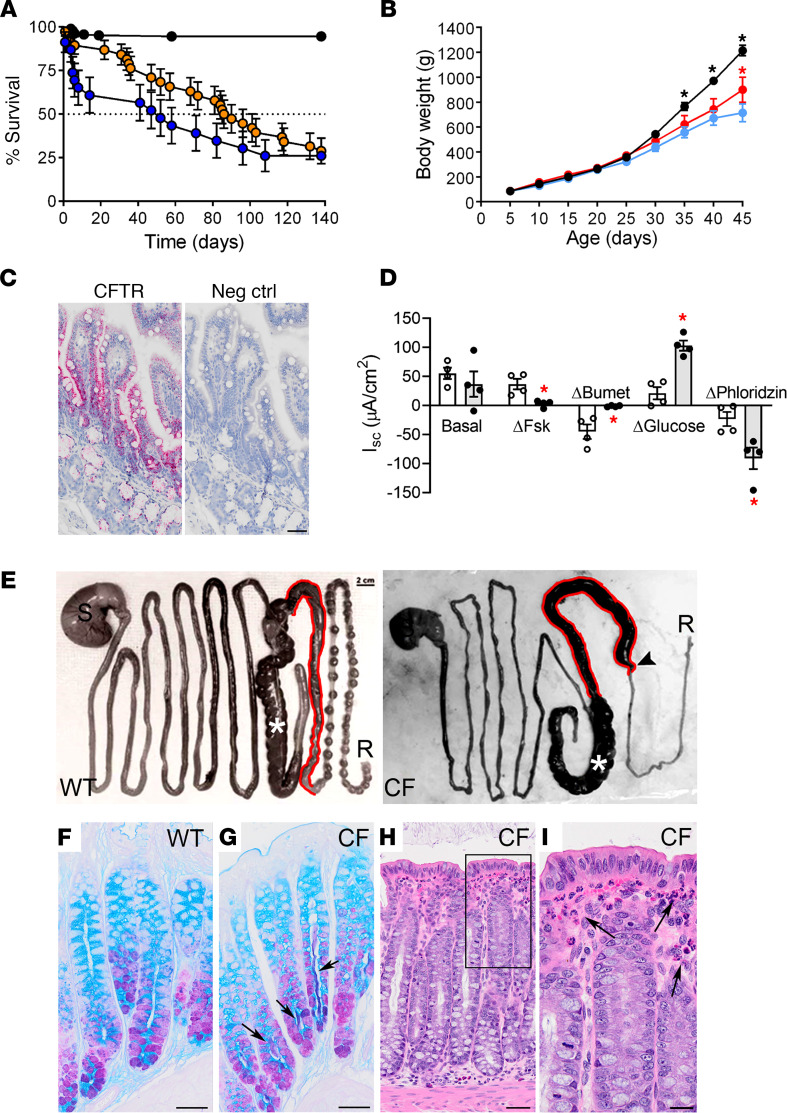
Characterization of CF rabbit gastrointestinal function, weight gain, and mortality.(A) Survival curves for WT and heterozygous rabbits (black, n = 190), CF rabbits on Golytely (blue, n = 23), and CF rabbits on Golytely, Bio-Serve, and abdominal palpation-directed GI therapy (orange, n = 38). (B) Weight gain for WT rabbits (black, n = 32), untreated CF rabbits (blue, n = 17), and CF rabbits treated with Golytely starting at P14 (red, n = 15). *P < 0.05 versus untreated CF, 2-way ANOVA with Tukey’s test for multiple comparisons. (C) mRNA in situ hybridization for rabbit CFTR or negative control (RNAscope, red chromogen) on sections of WT jejunum. Scale bar: 50 μm. Representative micrographs from n = 2 rabbits. (D) Ussing chamber characterization of freshly excised jejunal tissue from WT (white bar, white dots) and CF (gray bar, black dots) rabbits at approximately P52, illustrating short-circuit currents (Isc) under basal conditions, and after forskolin stimulation (ΔFsk), bumetanide inhibition (ΔBumet), glucose addition (Δglucose), and phloridzin inhibition. n = 4/genotype, *P < 0.05 versus WT. Unpaired, 2-tailed t test with Welch’s correction for unequal variance. (E) Freshly excised WT and CF gastrointestinal tract, deconvoluted from stomach (S) to rectum (R). Asterisk represents cecum. The proximal colon (highlighted in red) was dilated in CF rabbits as compared with WT, and there was a paucity of stool pellets in the distal colon of CF rabbits. Arrow indicates a site of obstruction. (F and G) (AB-PAS stained cross section of distal colon in approximately 3 months-old WT (F) (Scale bar: 0.1 mm) and CF (G) (Scale bar: 0.1mm) rabbits, demonstrating mucus retention (arrows) in the crypts of CF rabbits. (H and I) H&E-stained cross section of distal colon in approximately 3 months-old CF rabbit (H) (Scale bar: 50 μm) and high magnification of region of interest (I) (Scale bar: 20 μm) illustrating granulocytic infiltrates (arrows) in the intestinal submucosa. Representative micrographs from n = 4 CF and 4 WT rabbits.